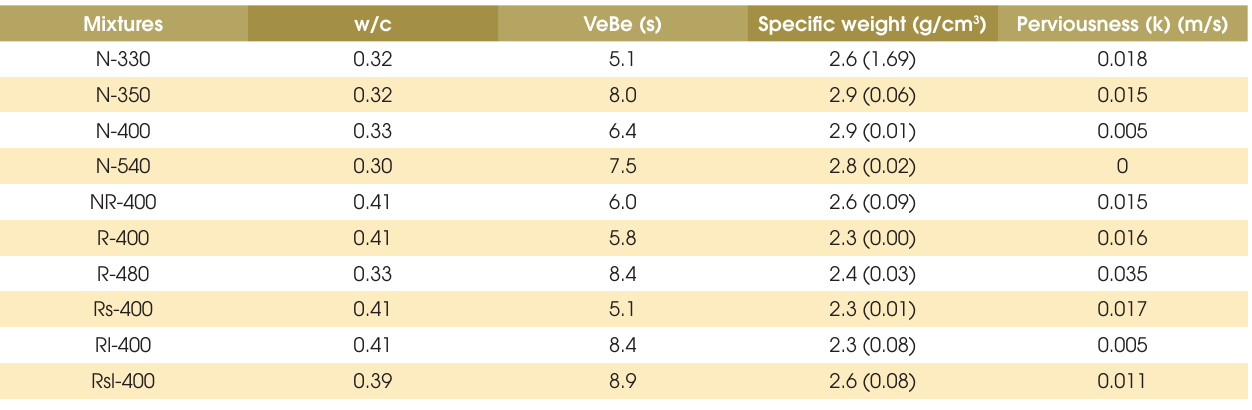
Table 4 – Specific weight and perviousness of set concrete mixtures, and consistency of fresh concretes using the VeBe method. Specific weight values are presented as means followed by the standard deviation. The standard deviation of perviousness values for all mixtures was below 0.002